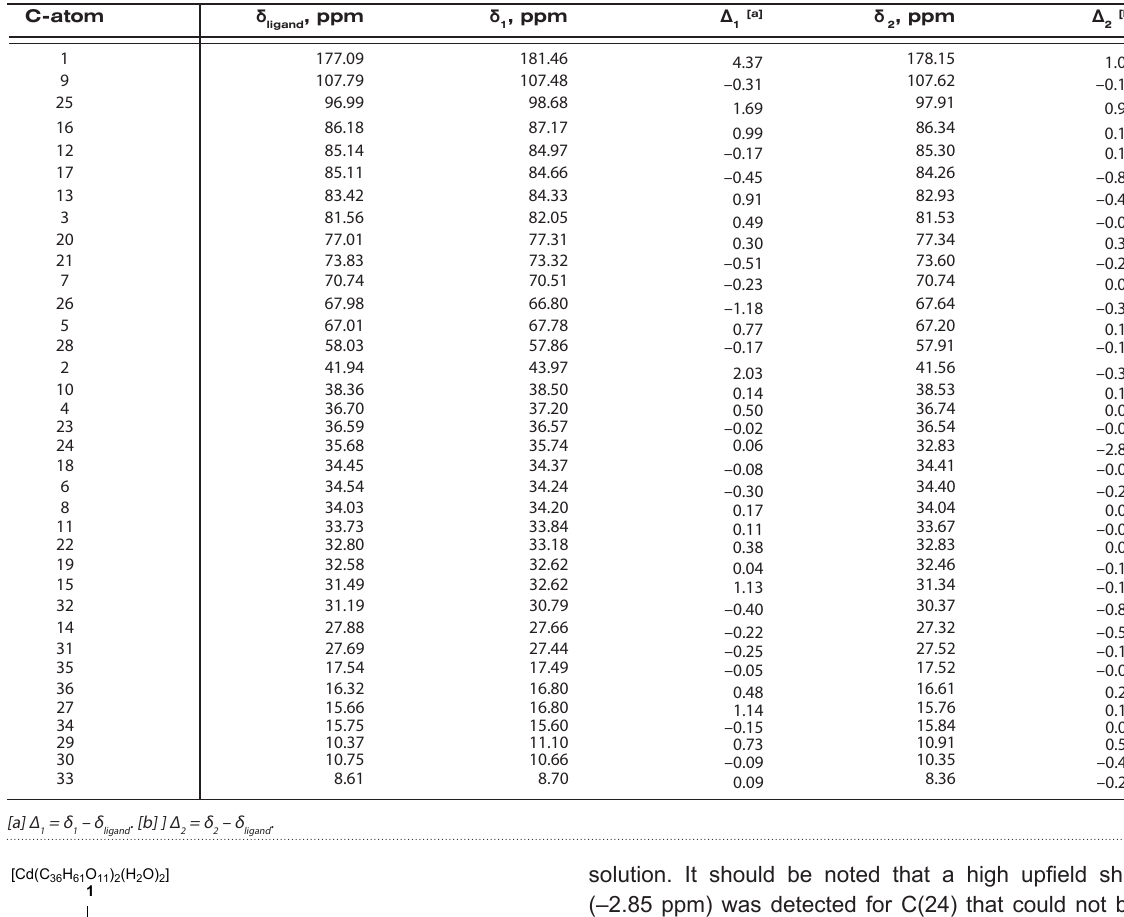
Table 6. 13 C { 1 H} NMR chemical shifts (150 MHz, CDCl